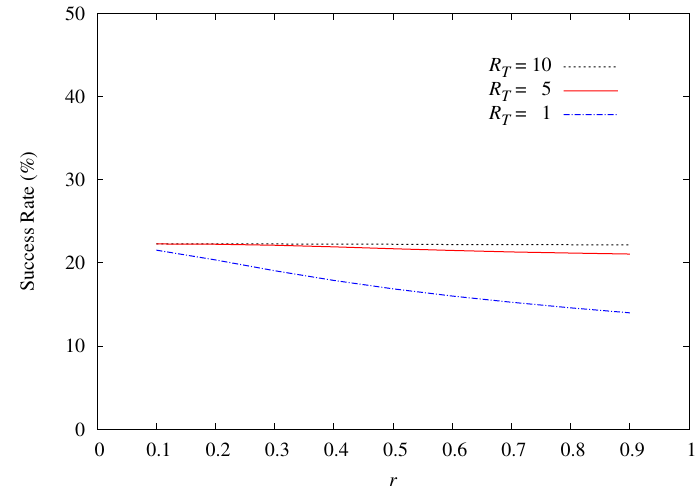
Figure 12. Impact of R T on discovery success rate.